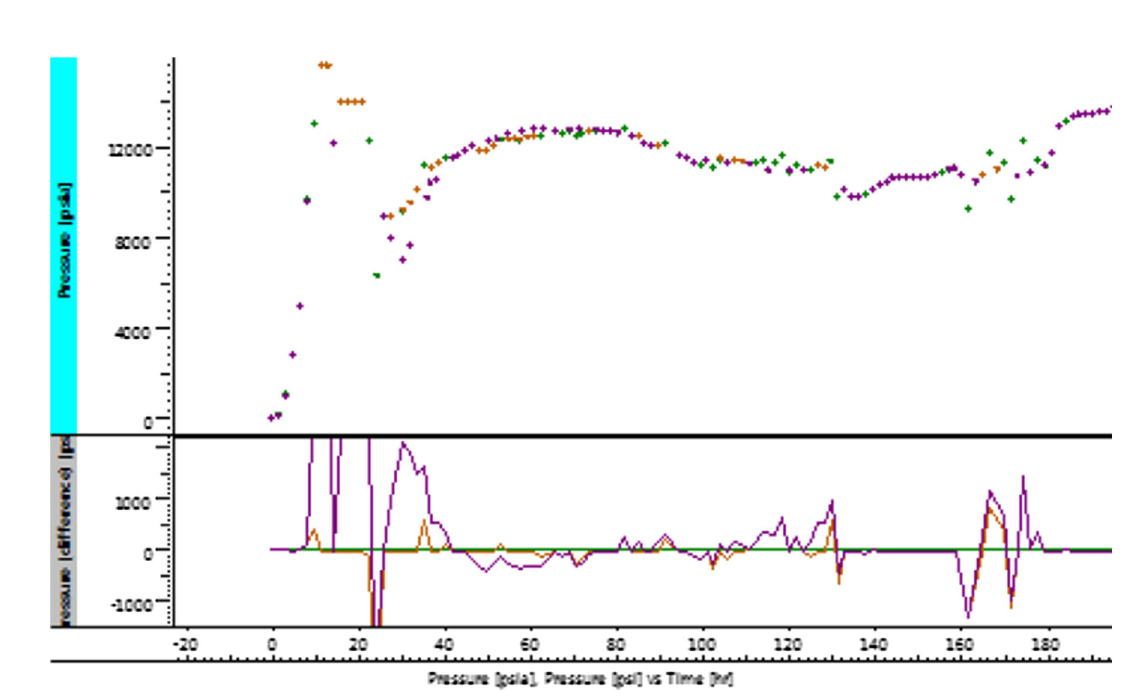
Fig. 1 Pressure plot (2 gauges with noisy